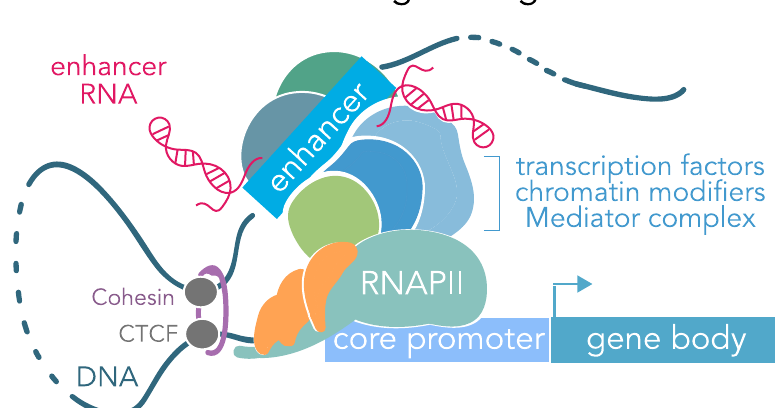
Figure 1. Regulation of gene expression patterns by genomic enhancers. Illustration of enhancer-promoter chromosomal looping (mediated by CTCF and cohesin) that allows distal enhancer elements to physically interact with and activate gene promoters. These interactions increase binding of transcription factors, chromatin modifiers, and the Mediator complex at gene promoters to recruit RNA polymerase II (RNAPII). Enhancers are characterized by elevated DNA sequence conservation, open chromatin, transcription factor binding motifs, characteristic histone modifications, DNA hypomethylation, and bidirectional transcription to generate enhancer RNAs (eRNAs).